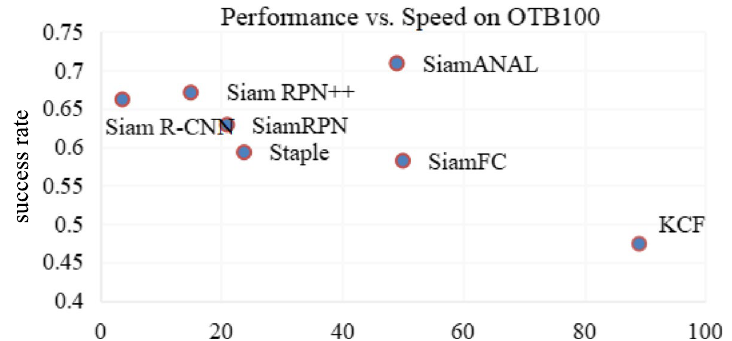
Fig. 9 Performance vs. speed on OTB100